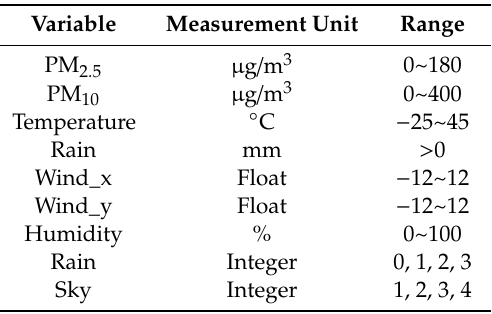
Table 3. Training data and model parameters.